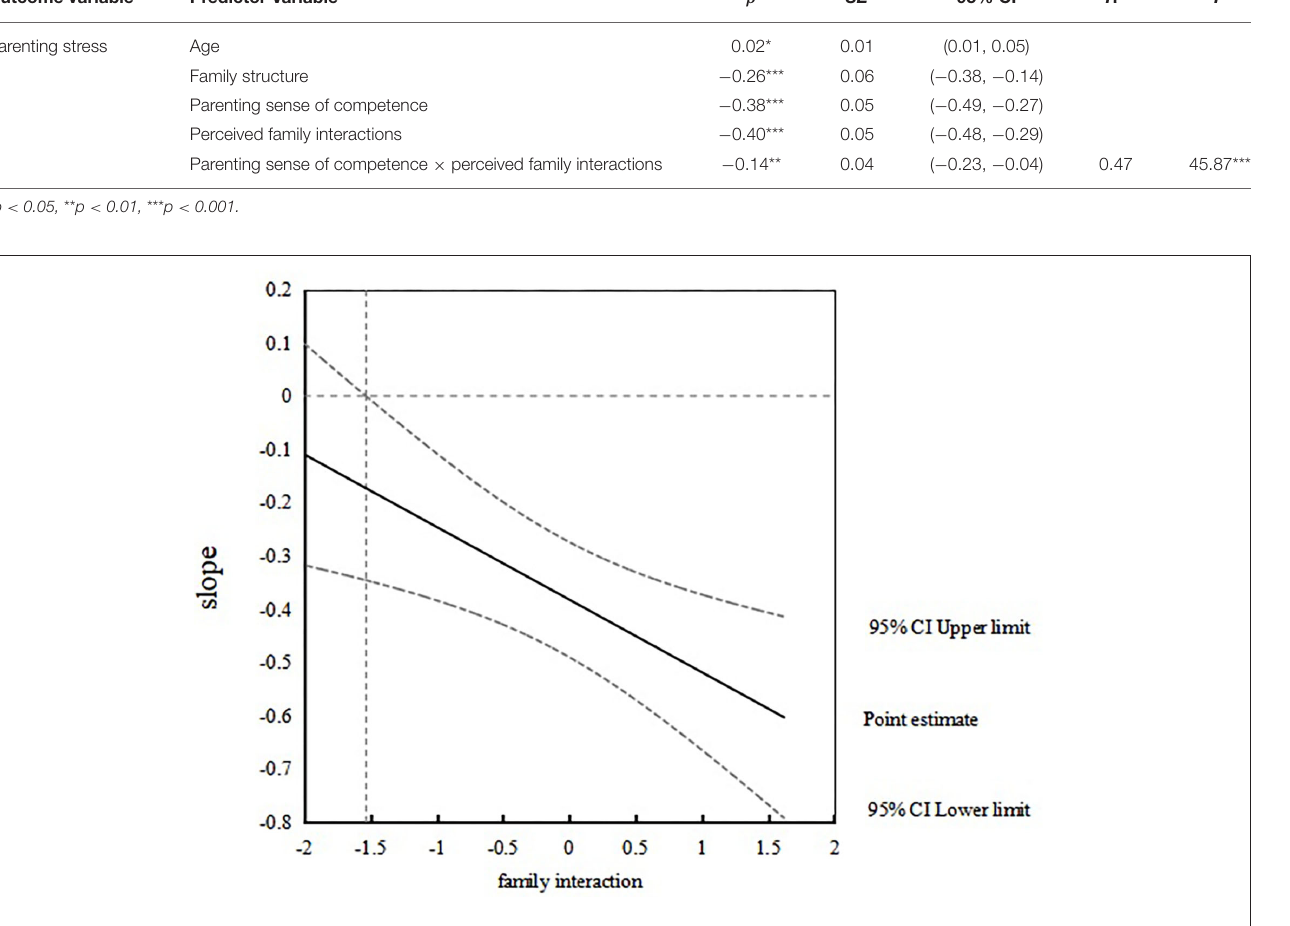
FIGURE 1 | The effect of parenting sense of competence on relationship parenting